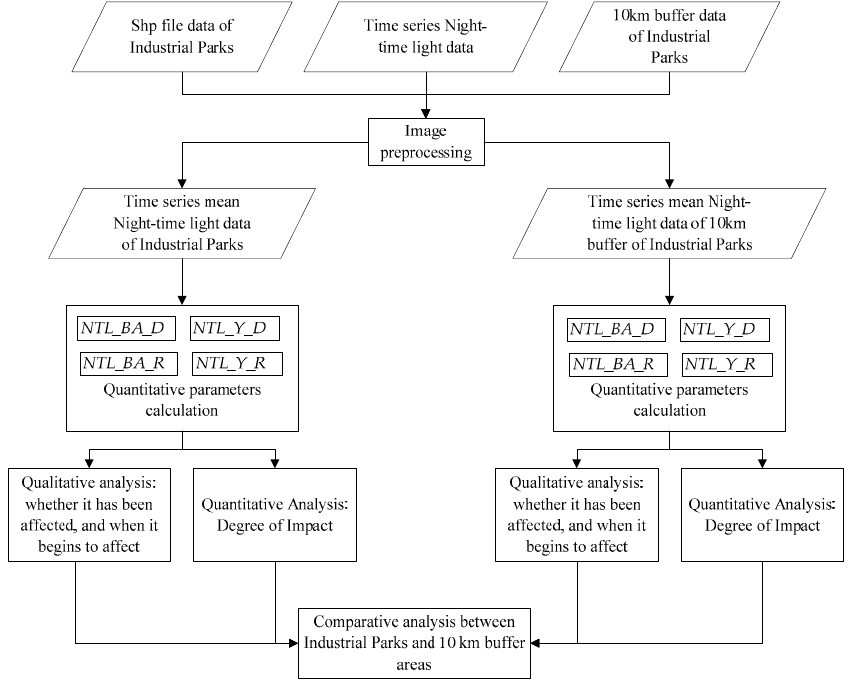
Figure 1. Flowchart of the proposed algorithm.